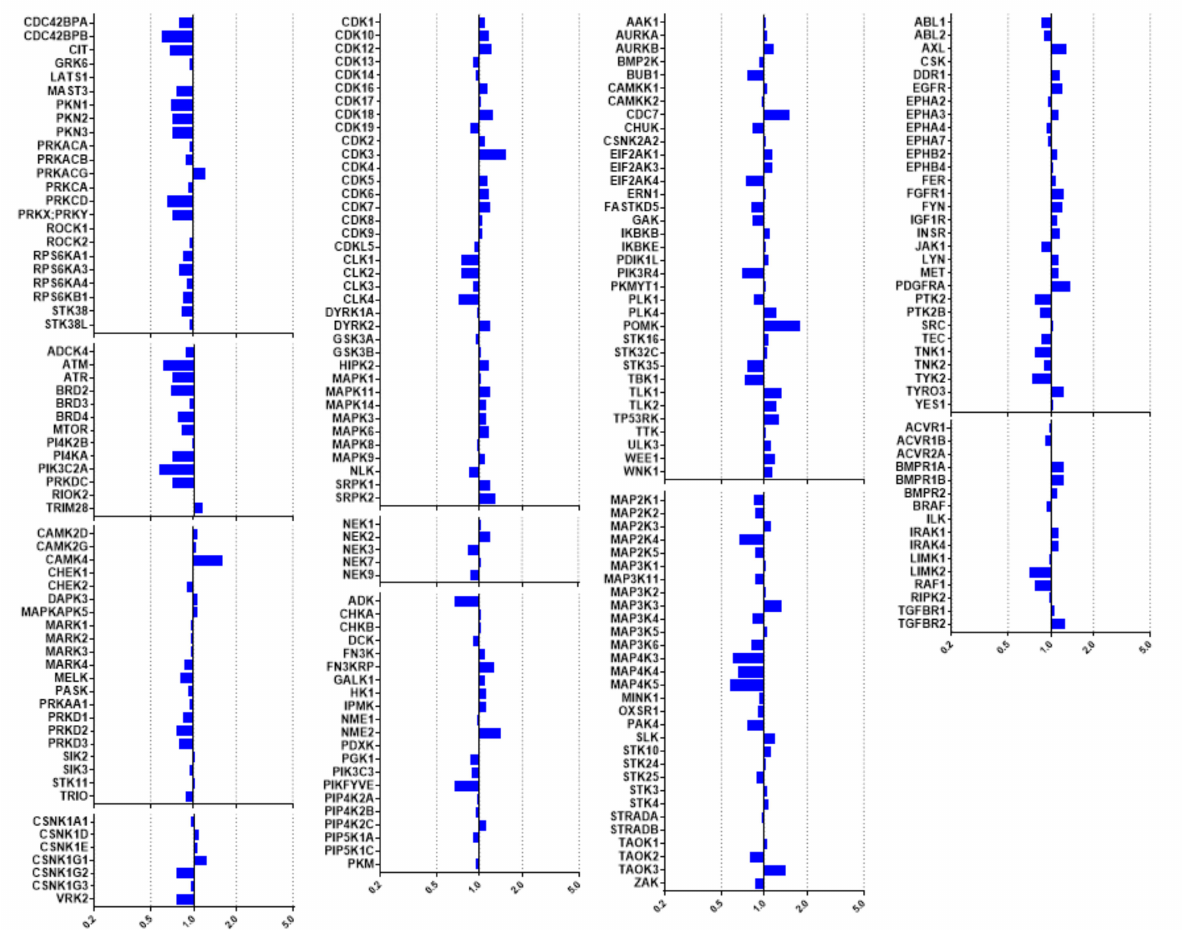
Figure 3. MIBS kinome profiling for thiadiazinone 16 (1 µ